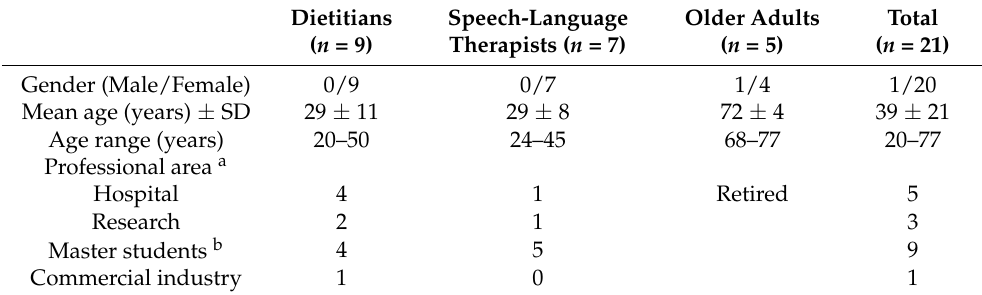
Table 3. Participant characteristics from the focus